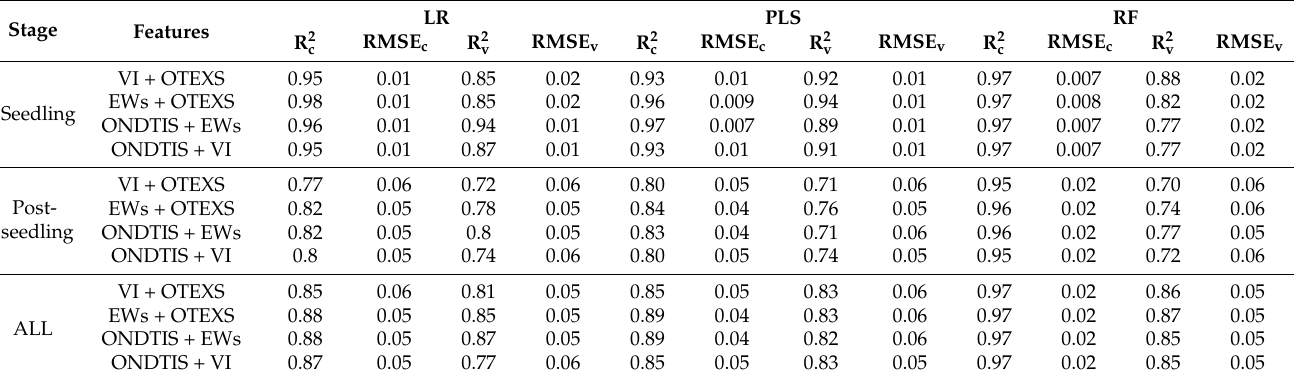
Table 9. Prediction results of LR, RF, and PLS with combined features across all di ff erent growth stages.